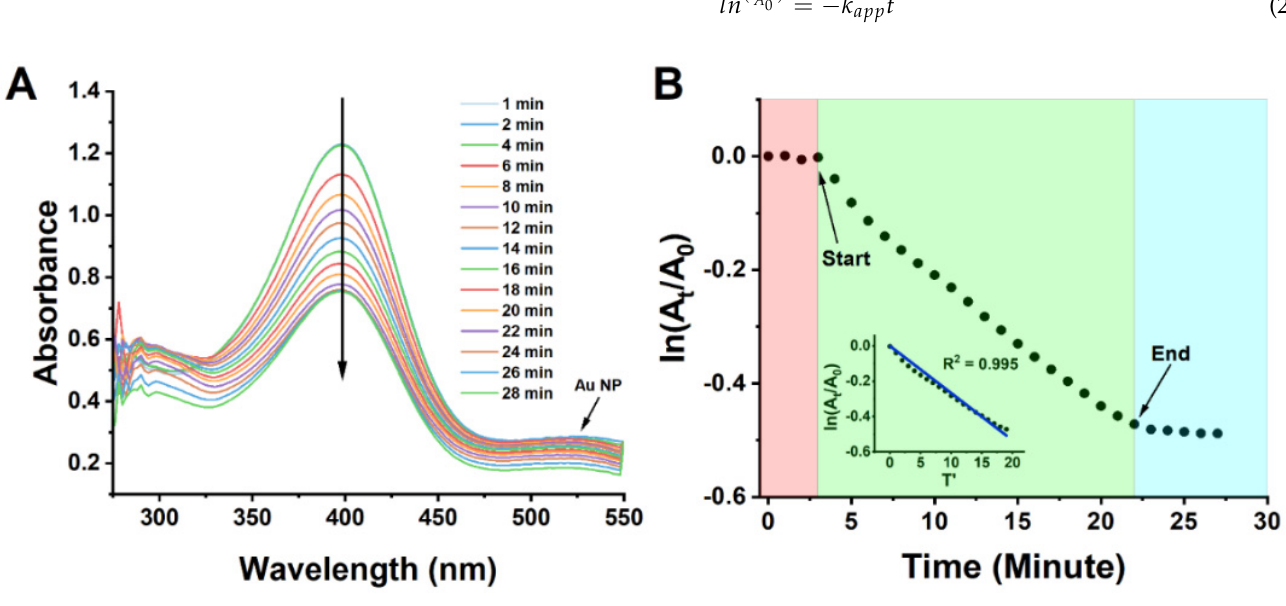
Figure 6. UV-vis spectra ( A ) at different time points and reaction kinetics. ( B ) The Au NP catalyzed reduction of 4-nitrophenol. T’ = T − 4.